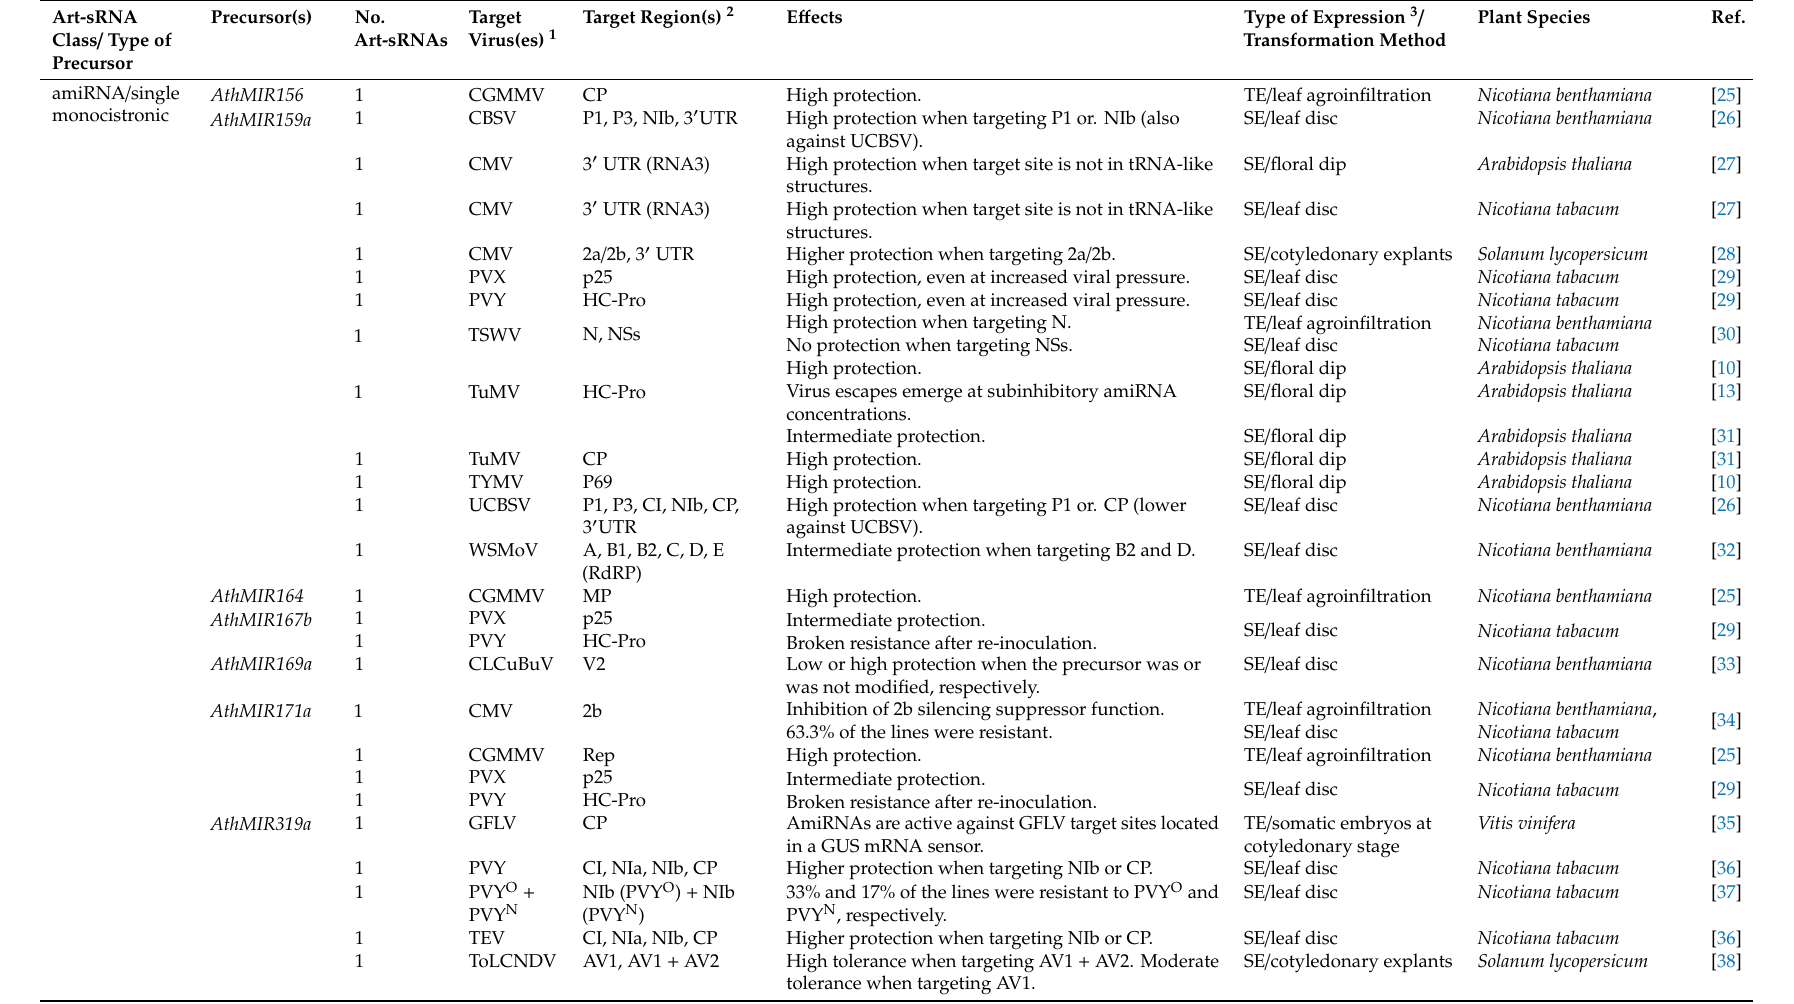
Table 1. Uses of art-sRNAi to induce antiviral resistance in